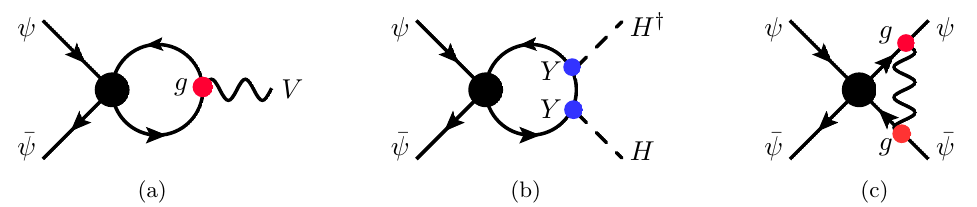
Figure 1 . Some leading diagrams contributing to dimension-6 operators with fermions. Black blobs denote strong interactions, while little red (blue) ones denote SM gauge (Yukawa) couplings that break SUSY